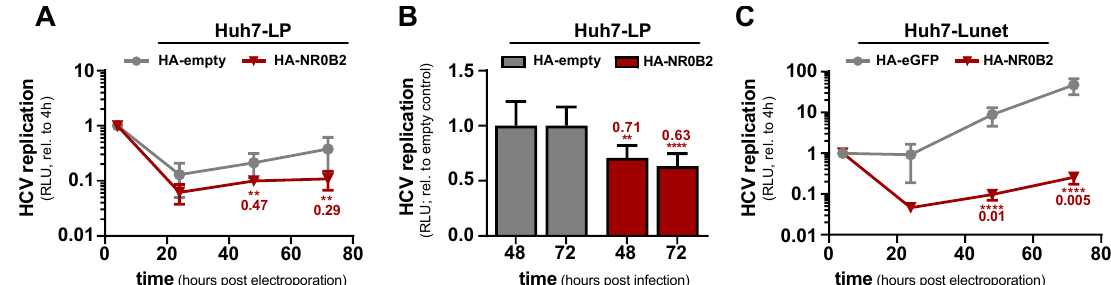
Figure 5. NR0B2 overexpression inhibits HCV replication in lowly and highly permissive Huh7 cells. ( A ) Replication of a subgenomic luciferase reporter replicon (gt1b) after electro-transfection into HA-NR0B2 overexpressing Huh7-LP cells compared to an HA-empty vector control in a time-course of 72 h. ( B ) Full-length Renilla luciferase reporter virus (JcR2a) replication in HA-NR0B2 overexpressing Huh7-LP cells compared to an HA-empty vector control after 48 and 72 h. ( C ) Replication of a subgenomic luciferase reporter replicon (gt1b) after electro-transfection into HA-NR0B2 overexpressing Huh7-Lunet cells compared to an HA-eGFP vector control in a time-course of 72 h. Luciferase data ( A , C ) is normalized to the signal four hours post electro-transfection and ( A–C ) show mean and standard deviation from at least three independent biological experiments. Significance was calculated using two-tailed, non-paired Student’s t -test. ** p ≤ 0.005, **** p ≤